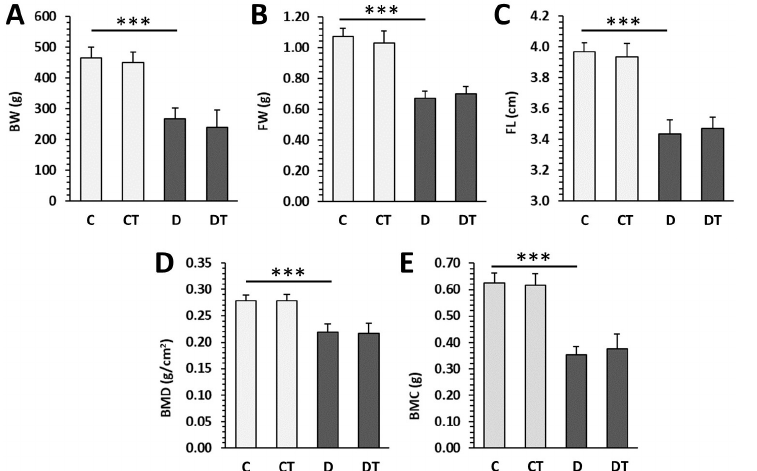
Figure 2. Macroscopic and densitometric parameters in non-diabetic rats (C), those treated with cemtirestat (CT), STZ-induced diabetic rats (D), and those treated with cemtirestat (DT). ( A ) Body weight (BW), ( B ) femoral weight (FW), ( C ) femoral length (FL), ( D ) bone mineral density (BMD), and ( E ) bone mineral content (BMC). The values are represented as mean ± SD. Only differences between groups C and D, as well as C and CT, and D and DT are indicated (*** p < 0.001).